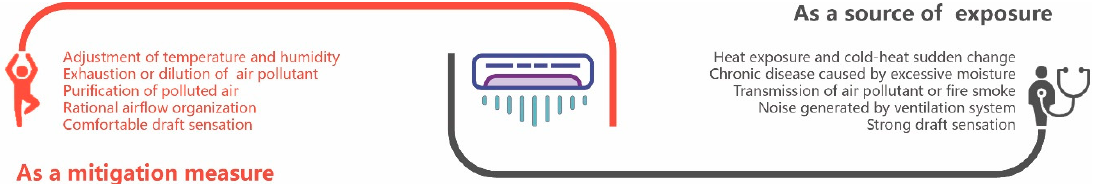
Figure 1. Dual effect of subway ventilation.